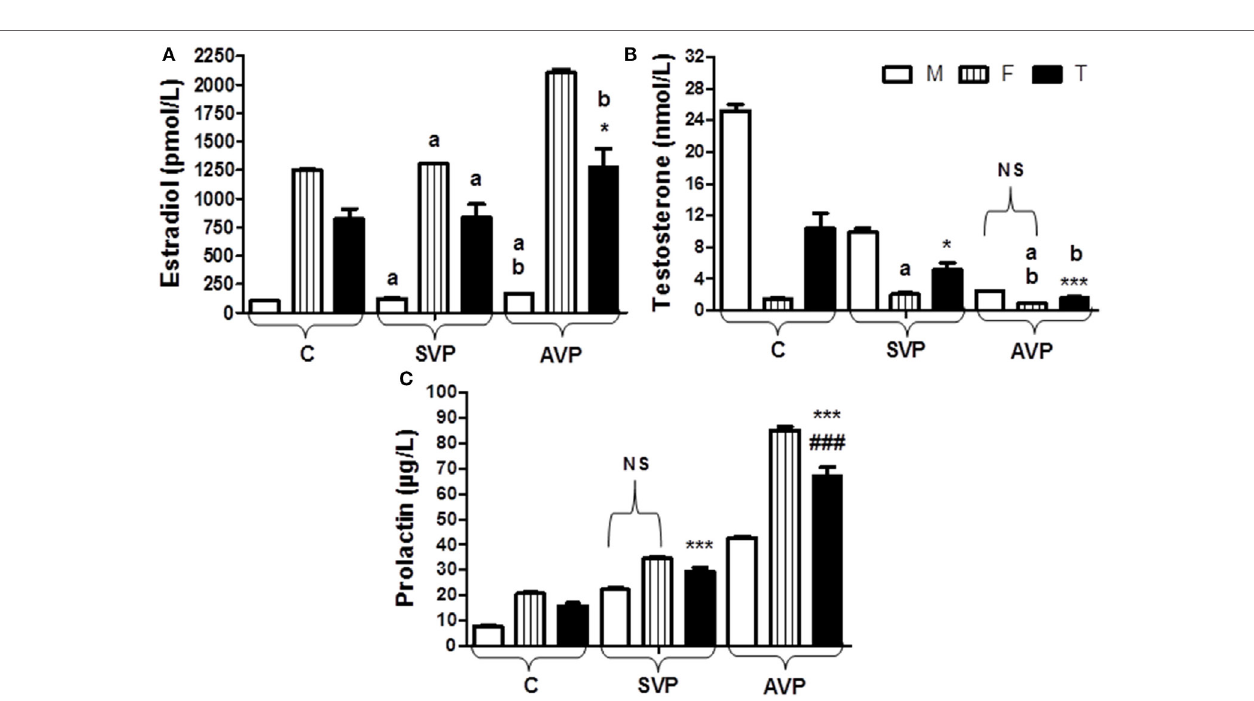
FigUre 5 | Serum levels of estradiol (a) , testosterone (B) , and prolactin (c) in vitiligo patients compared with control subjects. Values expressed as mean ± SEM. * p < 0.05, *** p < 0.001 significant vs. Control. ### p < 0.001 significant vs. SVP, a; non-significant vs. control, b; non-significant vs. SVP (between groups Total vs. Total; Male vs. Male; Female vs. Female). NS is a non-significant within group (Male vs. Female). Abbreviations: SVP, stable vitiligo patient; AVP, active vitiligo patient; M, male; F, female; T,